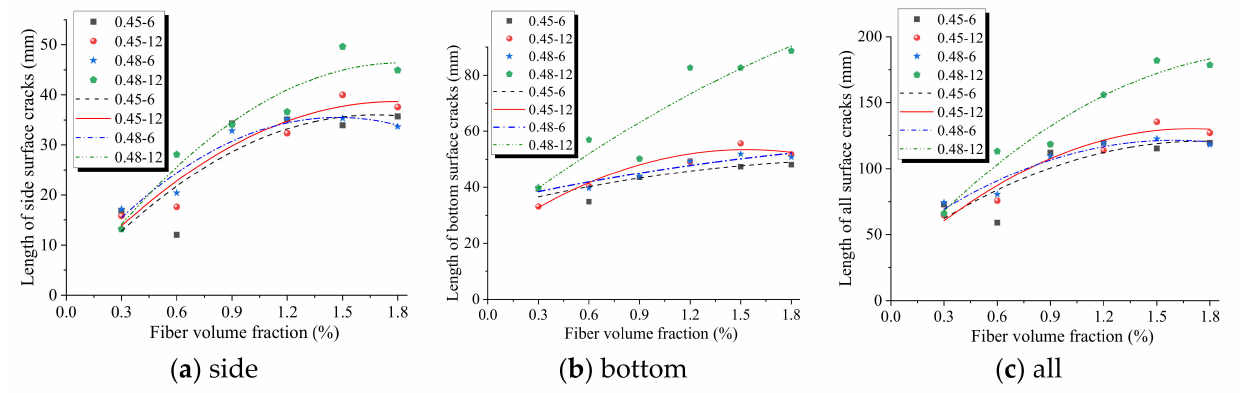
Figure 4. Relationship between fiber volume fraction and crack